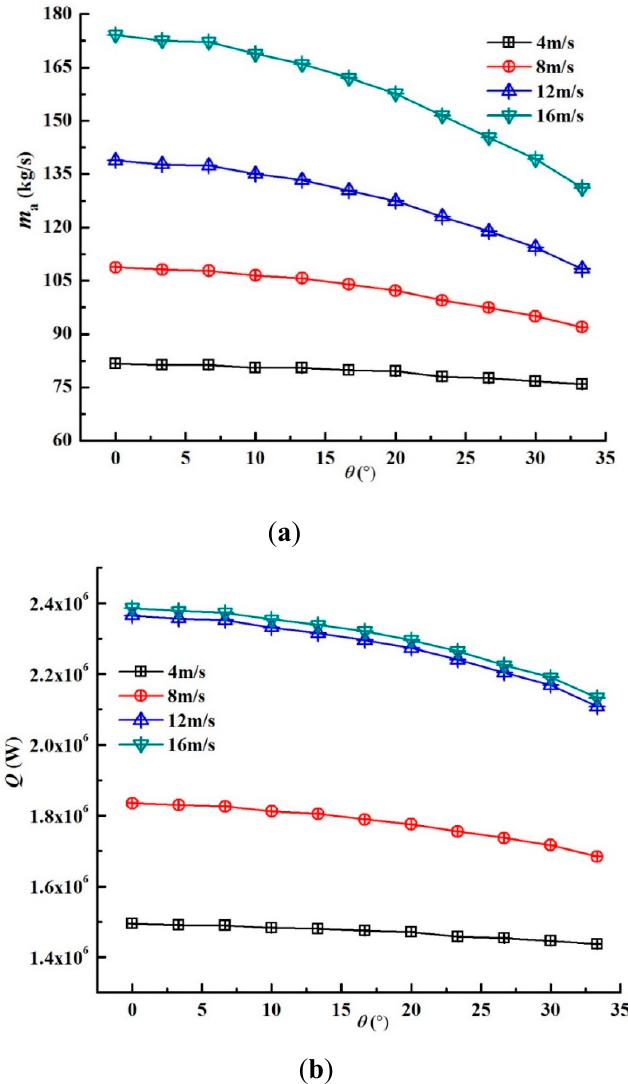
Figure 9. Thermo-flow performances of the frontal deltas. ( a ) Air mass flow rate, ( b ) heat